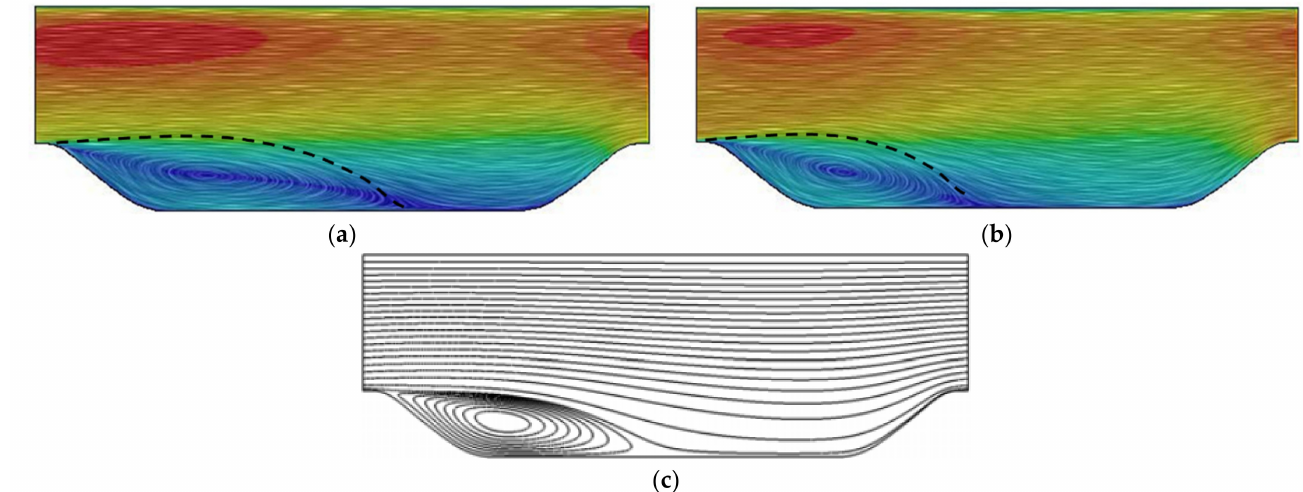
Figure 2. Comparison of streamline distributions between Realizable k − ε model (RKE) ( a ), STRUCT- ε ( b ) solutions and reference large eddy simulation (LES) data ( c ) [29] where red and blue vectors represent the high and low magnitude of velocity